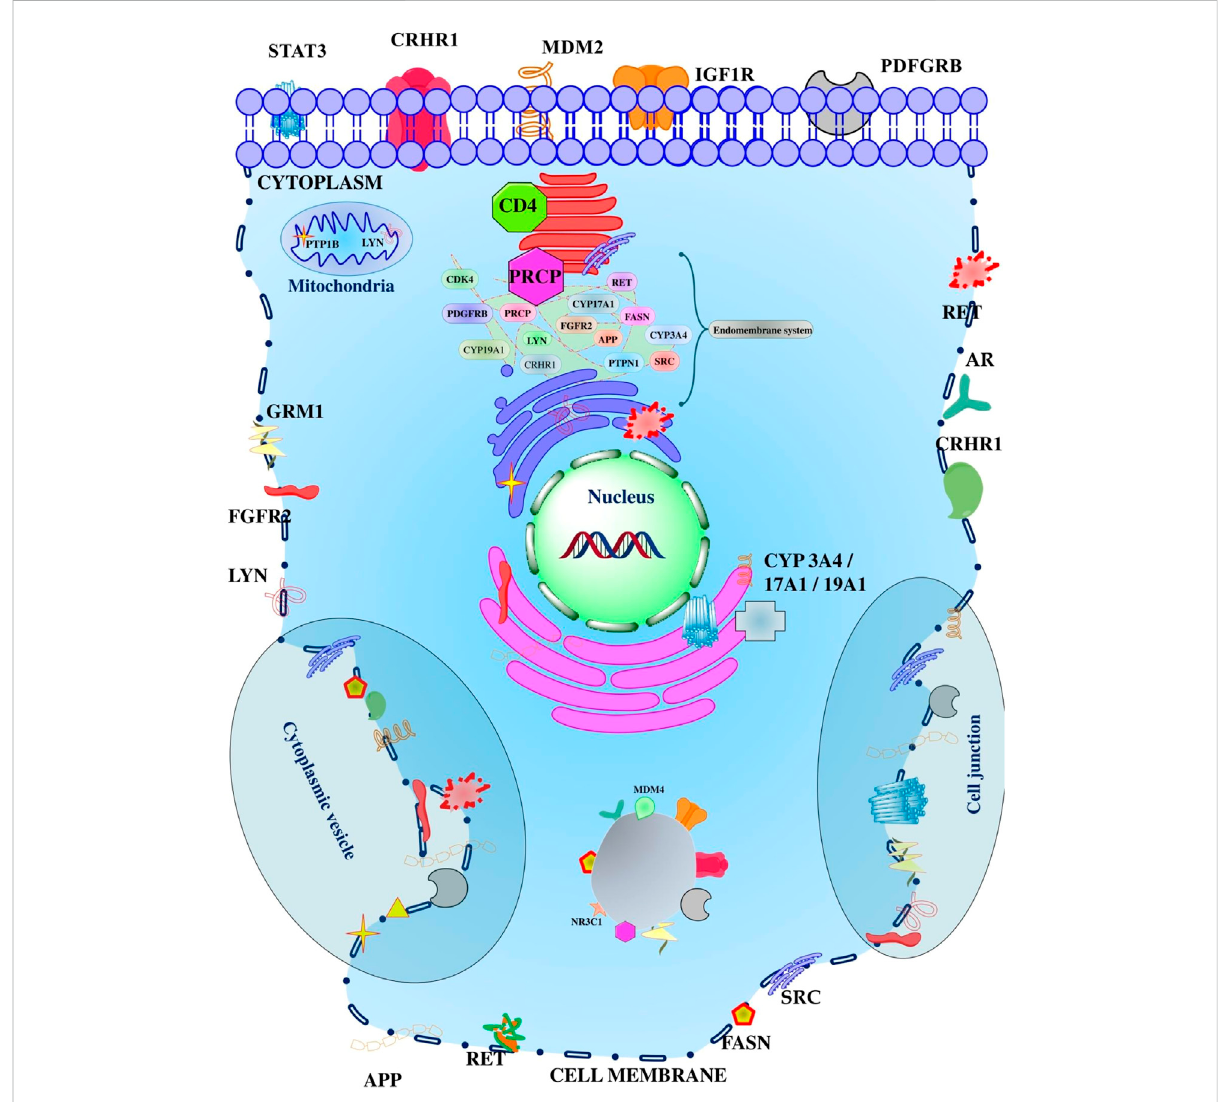
FIGURE 5 Different proteins affected by the diosgenin in the various compartment of the cell. The cellular organelles presented re fl ect the membrane- bounded organelle or intracellular organelle.